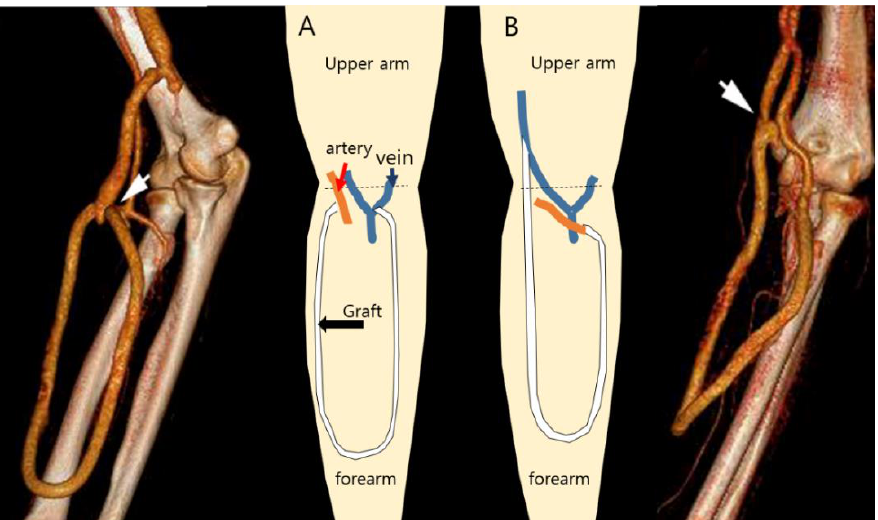
Figure 1. Configuration of the forearm loop access. Either superficial veins located in the antecubital fossa ( A ) or the basilic vein right above the elbow joint ( B ) can be selected as an outflow vein. When comparing with the antecubital veins as the outflow, the basilic vein above the elbow joint provides an almost parallel course to the graft. (Arrow: venous anastomosis).